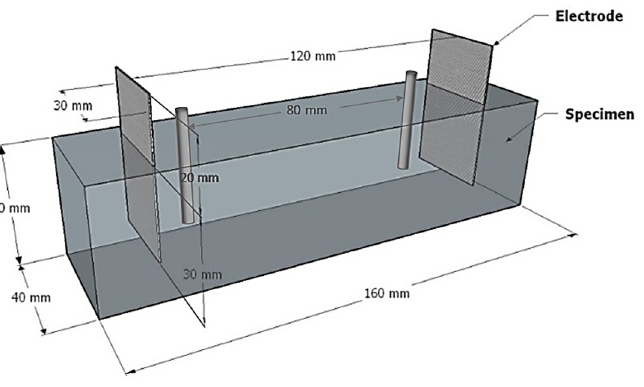
Figure 4. Specimen and electrode configuration for direct current (DC) and alternating current (AC) electrical resistivity measurements.